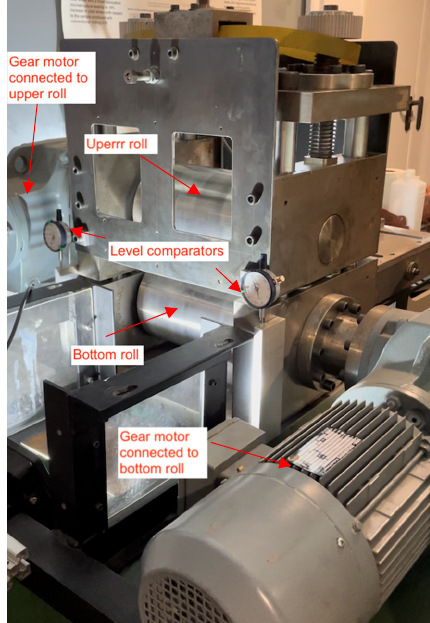
Figure 1. Asymmetric rolling mill.